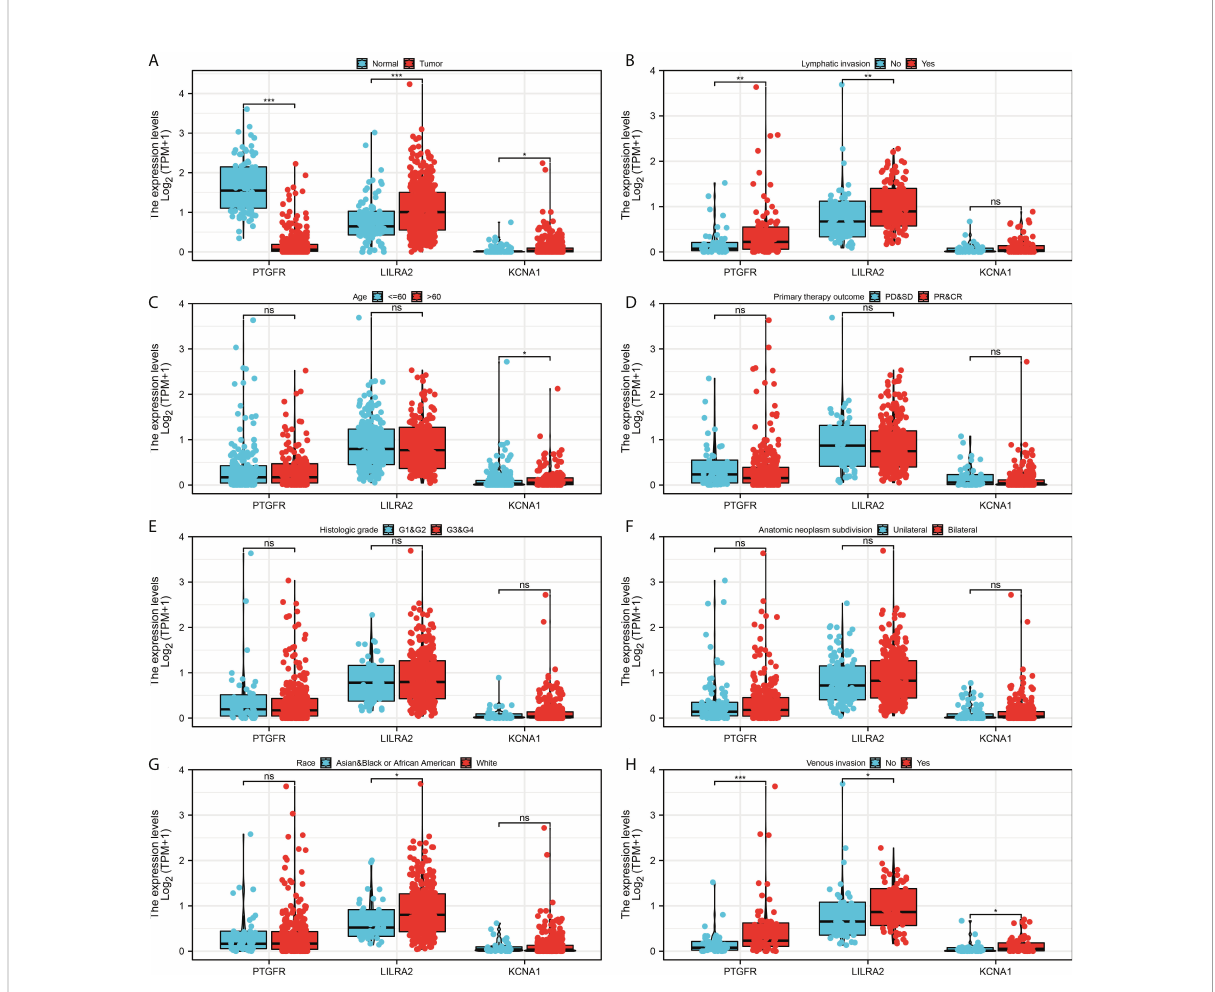
FIGURE 5 Clinical correlation of the model genes. (A) The expression level of model genes in normal and tumor tissue, * = P < 0.05, *** = P <0.001; (B) The expression level of model genes in patients with or without lymphatic invasion, ns = P > 0.05, ** = P < 0.01; (C) The expression level of model genes in <= 60 and > 60 years old patients, ns = P > 0.05, * = P < 0.05; (D) The expression level of model genes in patients with different primary therapy outcomes, ns = P > 0.05; (E) The expression level of model genes in patients with different histologic grade, ns = P > 0.05; (F) The expression level of model genes in patients with unilateral and bilateral anatomic neoplasm subdivision, ns = P > 0.05; (G) The expression level of model genes in different race patients, ns = P > 0.05, * = P < 0.05; (H) The expression level of model genes in patients with or without venous invasion, * = P < 0.05, *** = P